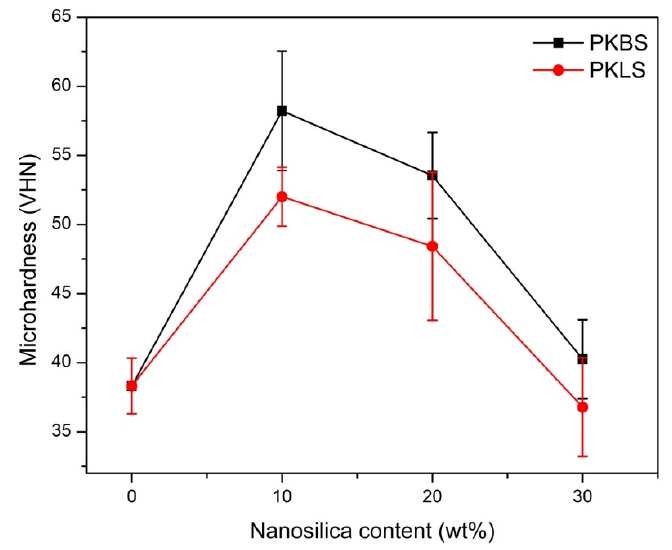
Figure 5. Mean value and standard deviations (mean ± SD) of microhardness for the PEEK/SiO 2 nanocomposites as a function of the nano-SiO 2 content. ( n = 7).